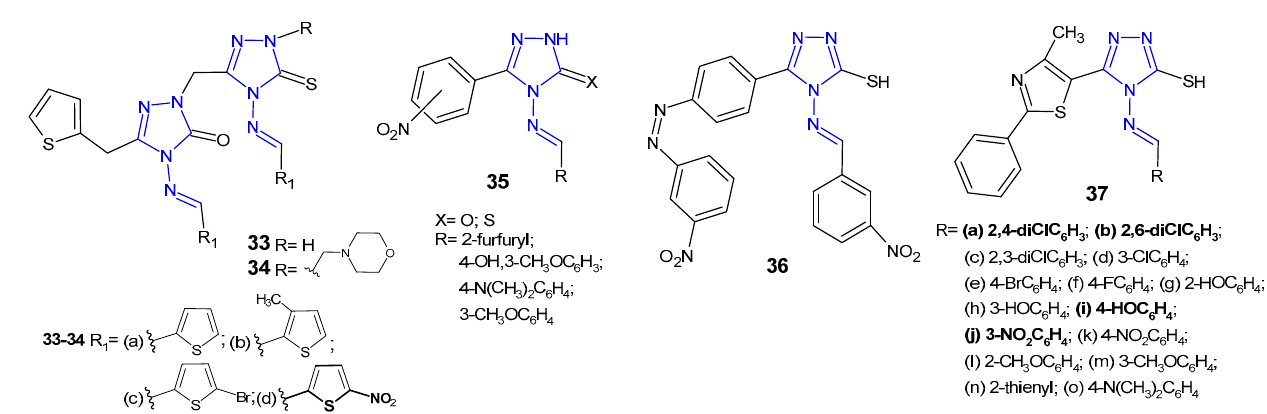
Figure 12. Antibacterial Schiff bases of 1,2,4-triazole – continued. Ünver et al. (2016) developed a series of hybrid 1,2,4-triazole molecules 33 – 34 (Figure 13) derived from Schiff and Mannich bases, and evaluated them for antibacterial activity against a panel of bacteria, namely E. coli , Y. pseudotuberculosis , P. aeruginosa , E. faecalis , S. aureus , B. cereus and Mycobacterium smegmatis . Among the new compounds, the Schiff base of methoxy group (CH 3 O), oxygen and NH in triazolone ring, and oxygen of hydroxy 33d carrying nitro substituent on the thiophene ring at the 4-position of 1,2,4-triazole group (HO) with three amino acid residues in the binding pocket of the enzyme, namely showed the highest inhibitory activity against all tested species, 2- or even 35-fold higher Ser347, Thr352 and Val399 [49]. than ampicillin. Compounds with morpholine 34 were generally less active [48].